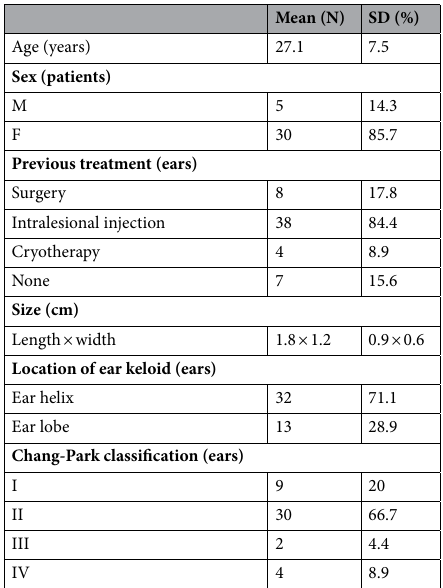
Table 1. Characteristics of patients and auricular keloids. F female, M male, N number, SD standard deviation.